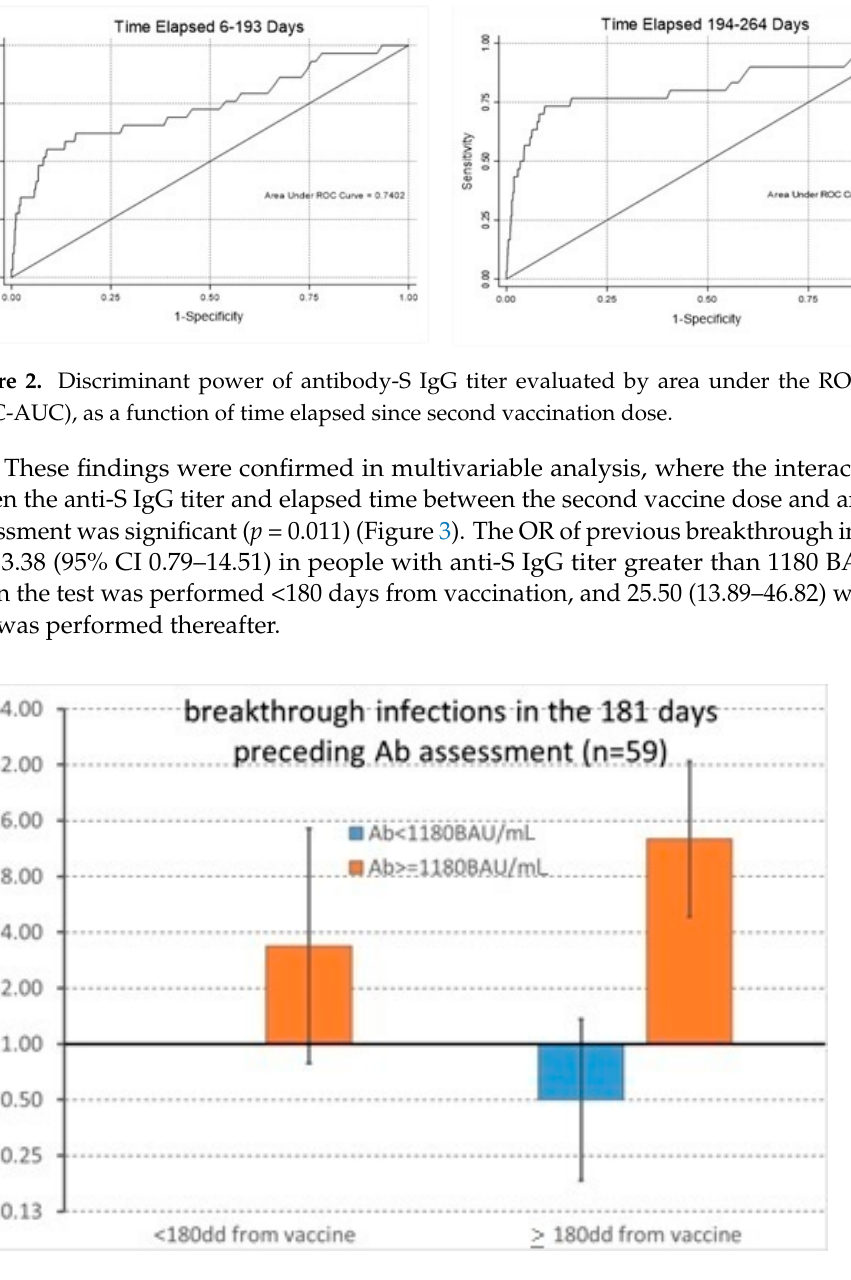
Figure 3. Odds ratios of previous breakthrough infection with corresponding 95% confidence intervals were computed with a logistic regression model controlling for sex, age, and job title.